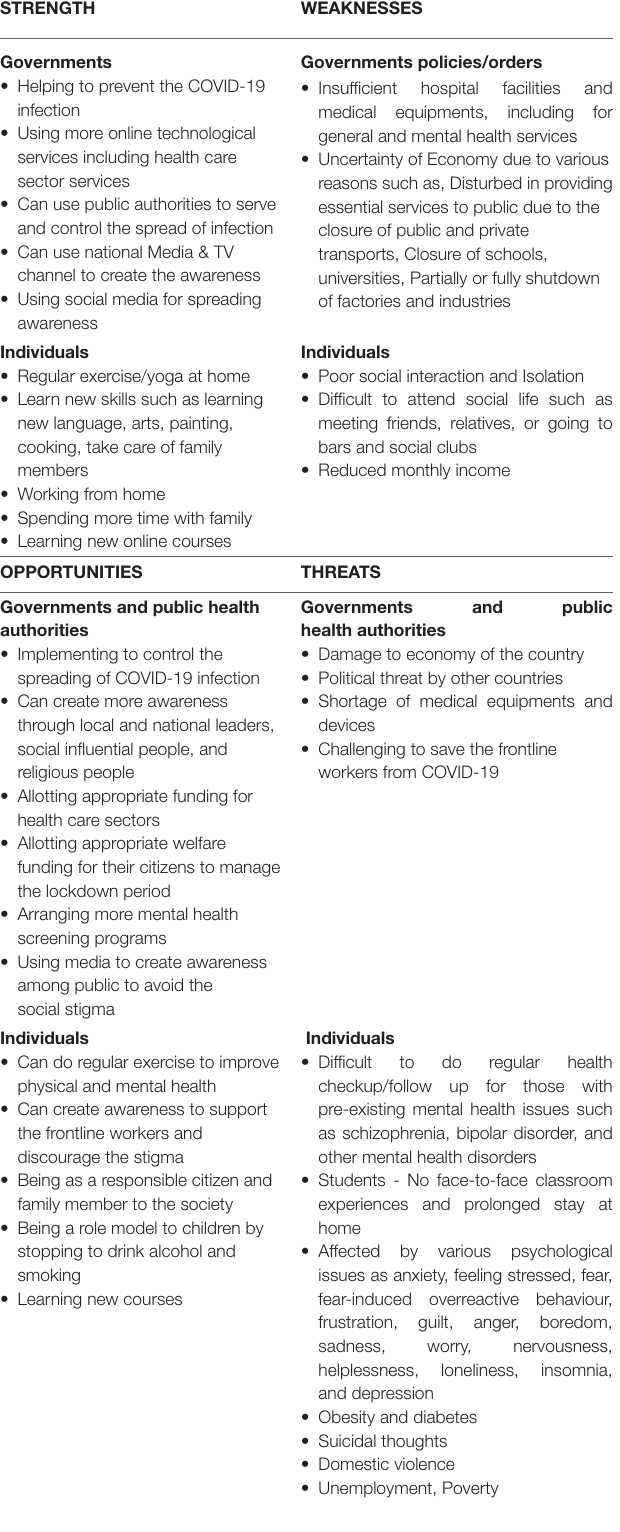
TABLE 2 | SWOT: COVID-19 preventive measures (quarantine, isolation, lockdown, and social distancing) and mental health. STRENGTH